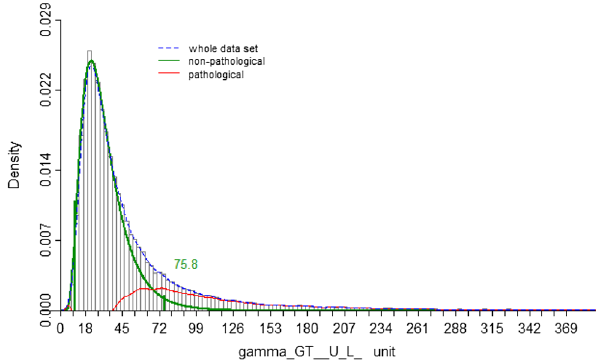
Figure 4: Estimation of the reference interval (RI) for ɣ -glutamyl transpeptidase with truncated maximum likelihood, TML (taken from ref. [25]).